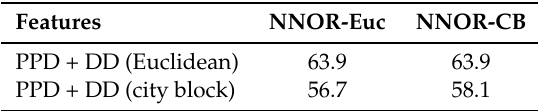
Table 4. Results of leave-one-subject-out, 5-fold cross-validation tests obtained for Dataset 1 using nearest neighbor classifier with orientation restriction (NNOR).